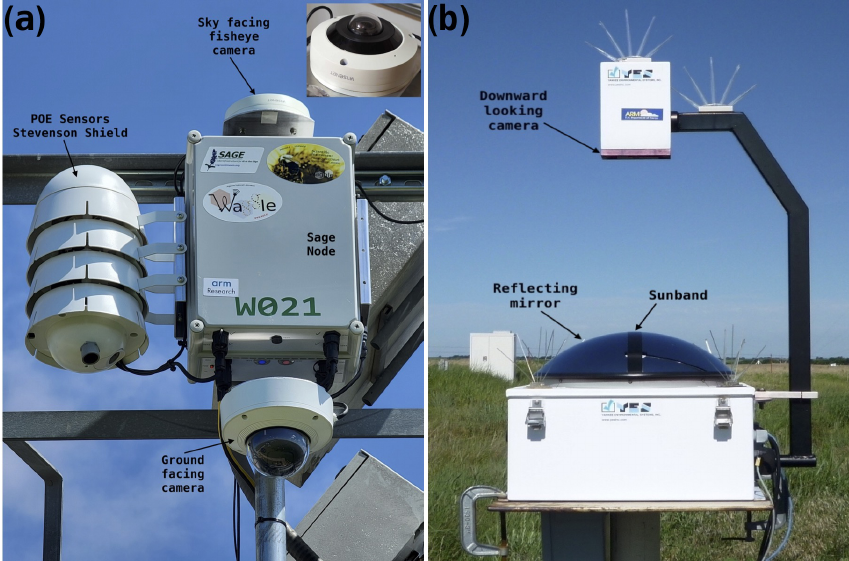
Figure 1. (a) Sage node deployment at the Atmospheric Radiation Measurement (ARM) user facility in Lamont, OK., with a fisheye camera for sky monitoring. (b) Downward-looking total sky imager (TSI) with rotating mirror sunband and